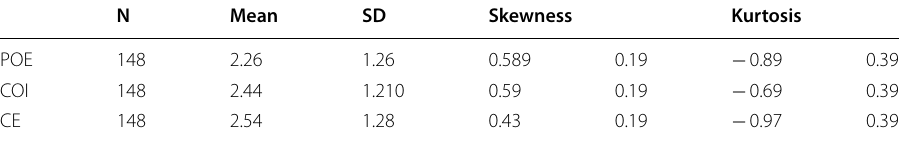
Table 4 Descriptive statistics for L2 grit (POE & COI), and CE in public school students N